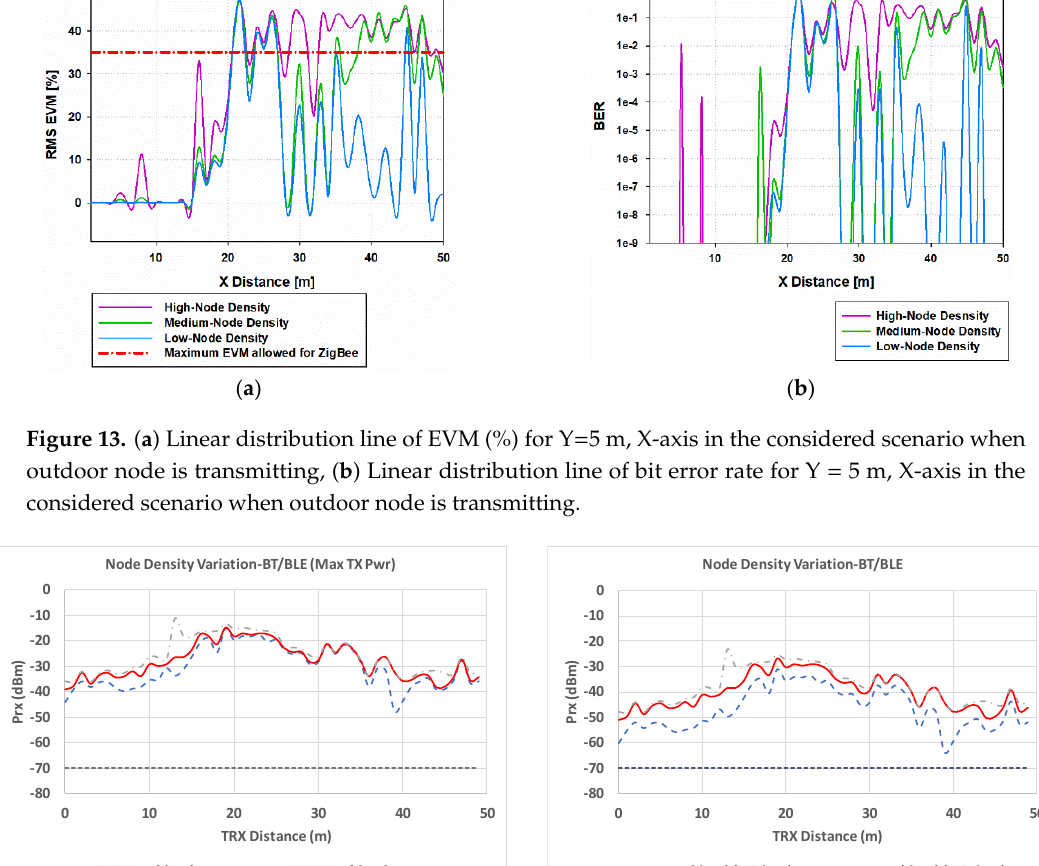
Figure 13. ( a ) Linear distribution line of EVM (%) for Y=5 m, X-axis in the considered scenario when outdoor node is transmitting, ( b ) Linear distribution line of bit error rate for Y = 5 m, X-axis in the considered scenario when outdoor node is transmitting.